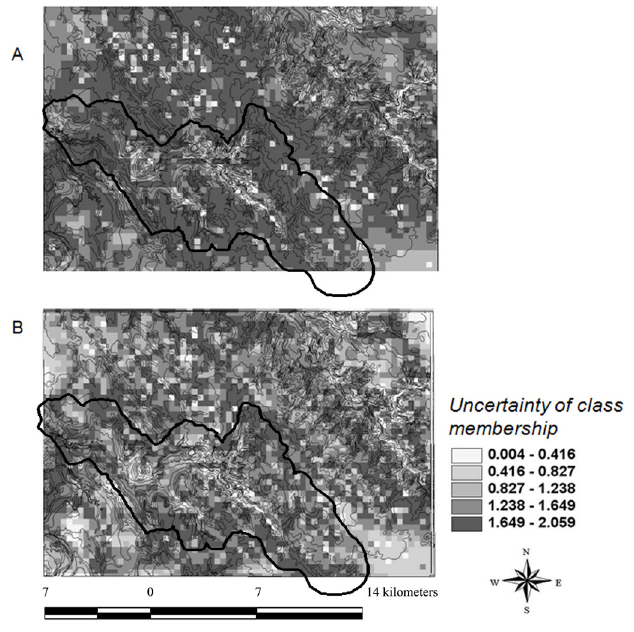
Figure 7: Uncertainty of class membership for the multiscale cartographic models of soil-vegetation classes based on water-sensitive (A) and nutrient-sensitive (B) properties. Bold black curve – boundary of the Zayachya river